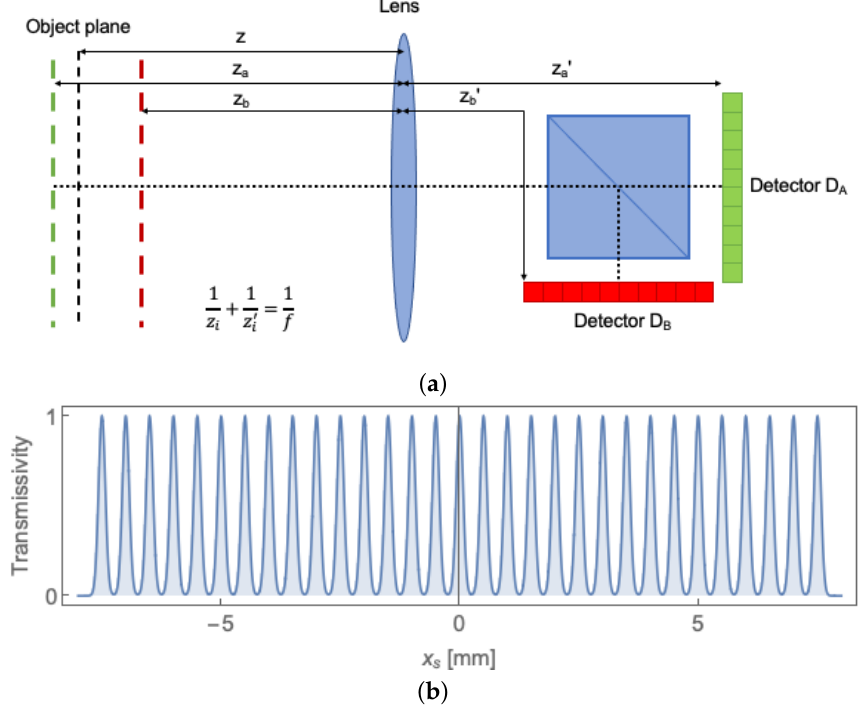
Figure 2. ( a ) Example of a CPI setup, named correlation plenoptic imaging between arbitrary planes [23]. A source of thermal light is placed on the object plane, and plays the role of both the illuminating source and the object (e.g., a fluorescent object). Photons from the object propagate through a single lens with focal length f and, after being separated by a beam-splitter, are collected by two spatially- resolving detectors D A and D B . The planes optically conjugated to the detectors do not coincide ( z a (cid:54) = z b ) and, in the most general case, the object is placed out of focus with respect to both detectors ( z (cid:54) = z a , b ). Details about the experimental parameters can be found in the text. This setup is used to generate all the simulations reported in this work. ( b ) The intensity transmissivity of the object used for the simulations ( | A ( x s ) | 2 ). The object is an indefinitely extended set of equally-spaced (500 µ m) Gaussian apertures of width 100 µ